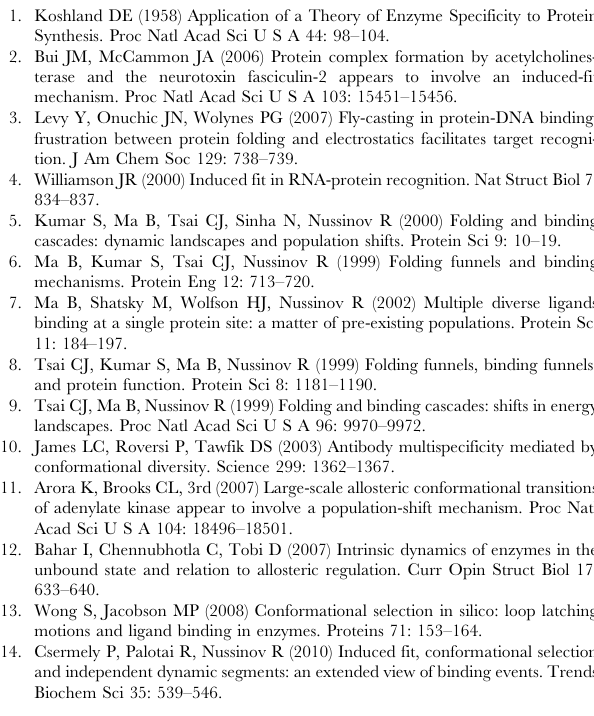
cartoon representation while the residues within a cutoff of 8 A˚ from the ligand in the crystal structure of 1LAF are shown in lines. In these conformations, we found the ligand side chain interacts with the lobe I Tyr14 and Phe52 through cation-Pi interactions. From five out of the six conformations, we also observed that the NH 3 COO 2 group of the ligand protrudes upward to interact with the lobe II residue Thr121. The same interactions are also observed in the X-ray bound structure. Figure S5 Superposition of the 5 highest flux pathways from mis-bound states to the bound state. The flux was calculated using a greedy backtracking algorithm from a 53-state Markov State Model (MSM) generated with the SHC algorithm. The arrow size is proportional to the interstate flux. (a) Representative structures and equilibrium populations are shown for each state. (b) Free energy plots of protein opening versus twisting angle are shown. The macrostate number is inserted in each of the free energy plots. Figure S6 The ligand distance to the binding site vs. simulation time was plotted for 12 MD simulations where binding (11 simulations) or unbinding (1 simulation, gray shaded) events were observed. Figure S7 Ligand rotational autocorrelation functions for the unbound states (blue), the encounter complex state (green), and the bound state (red) are shown in the left panel. Autocorrelation functions generated from different trajectories are overlaid in the same figure. On the right panel, a schematic figure illustrates that the ligand rotates quickly when it is far away from the protein but the ligand rotation is restrained when it interacts with the protein.